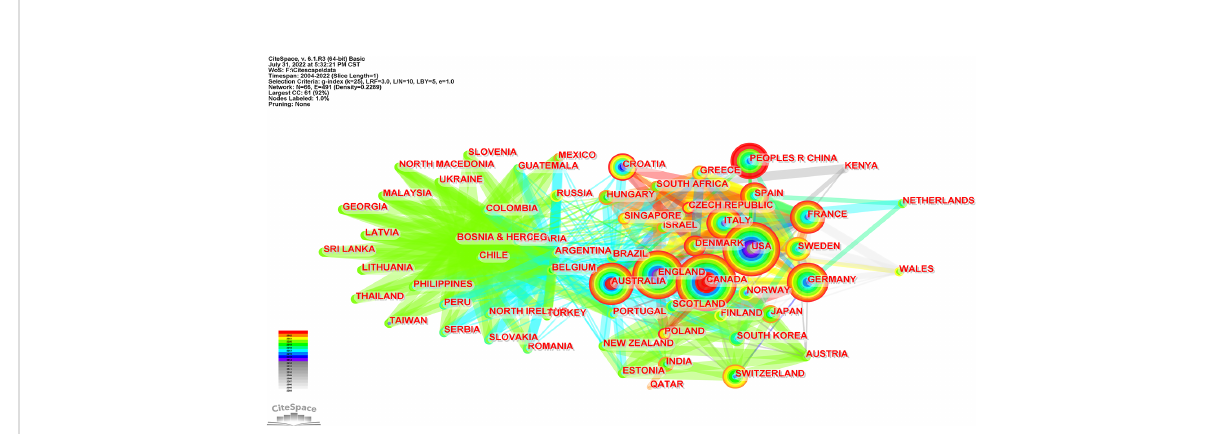
FIGURE 5 Visualization map of countries/regions collaboration analysis related to RNA methylation in DM and its complications. Each node with colorful annual rings represents a country; the color bandwidth corresponds to the outputs of the year; the wider the ribbon, the higher the number of outputs posted and the corresponding node increases. The purple color around the nodes represents high centrality. Link between the two nodes represents the cooperation relationship, and the link color represents the initial cooperation year.